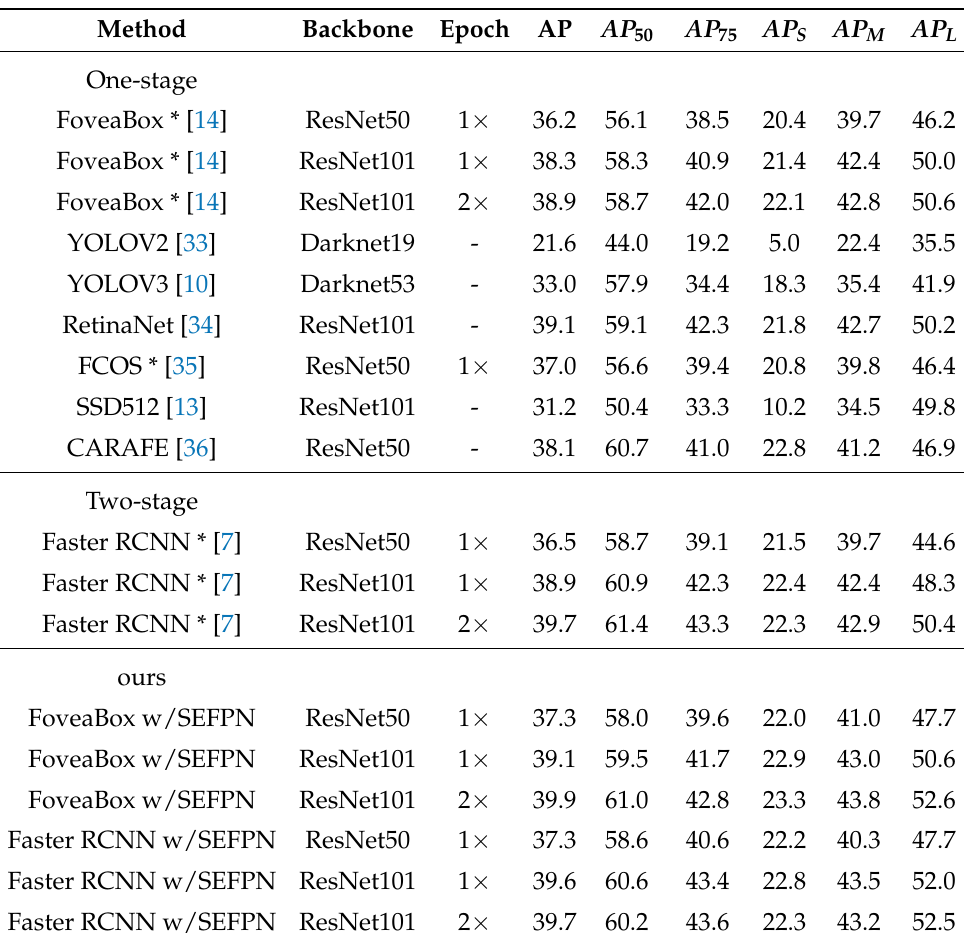
Table 1. Comparison with the state-of-the-art results on MS-COCO, symbol “*” means our re- implemented